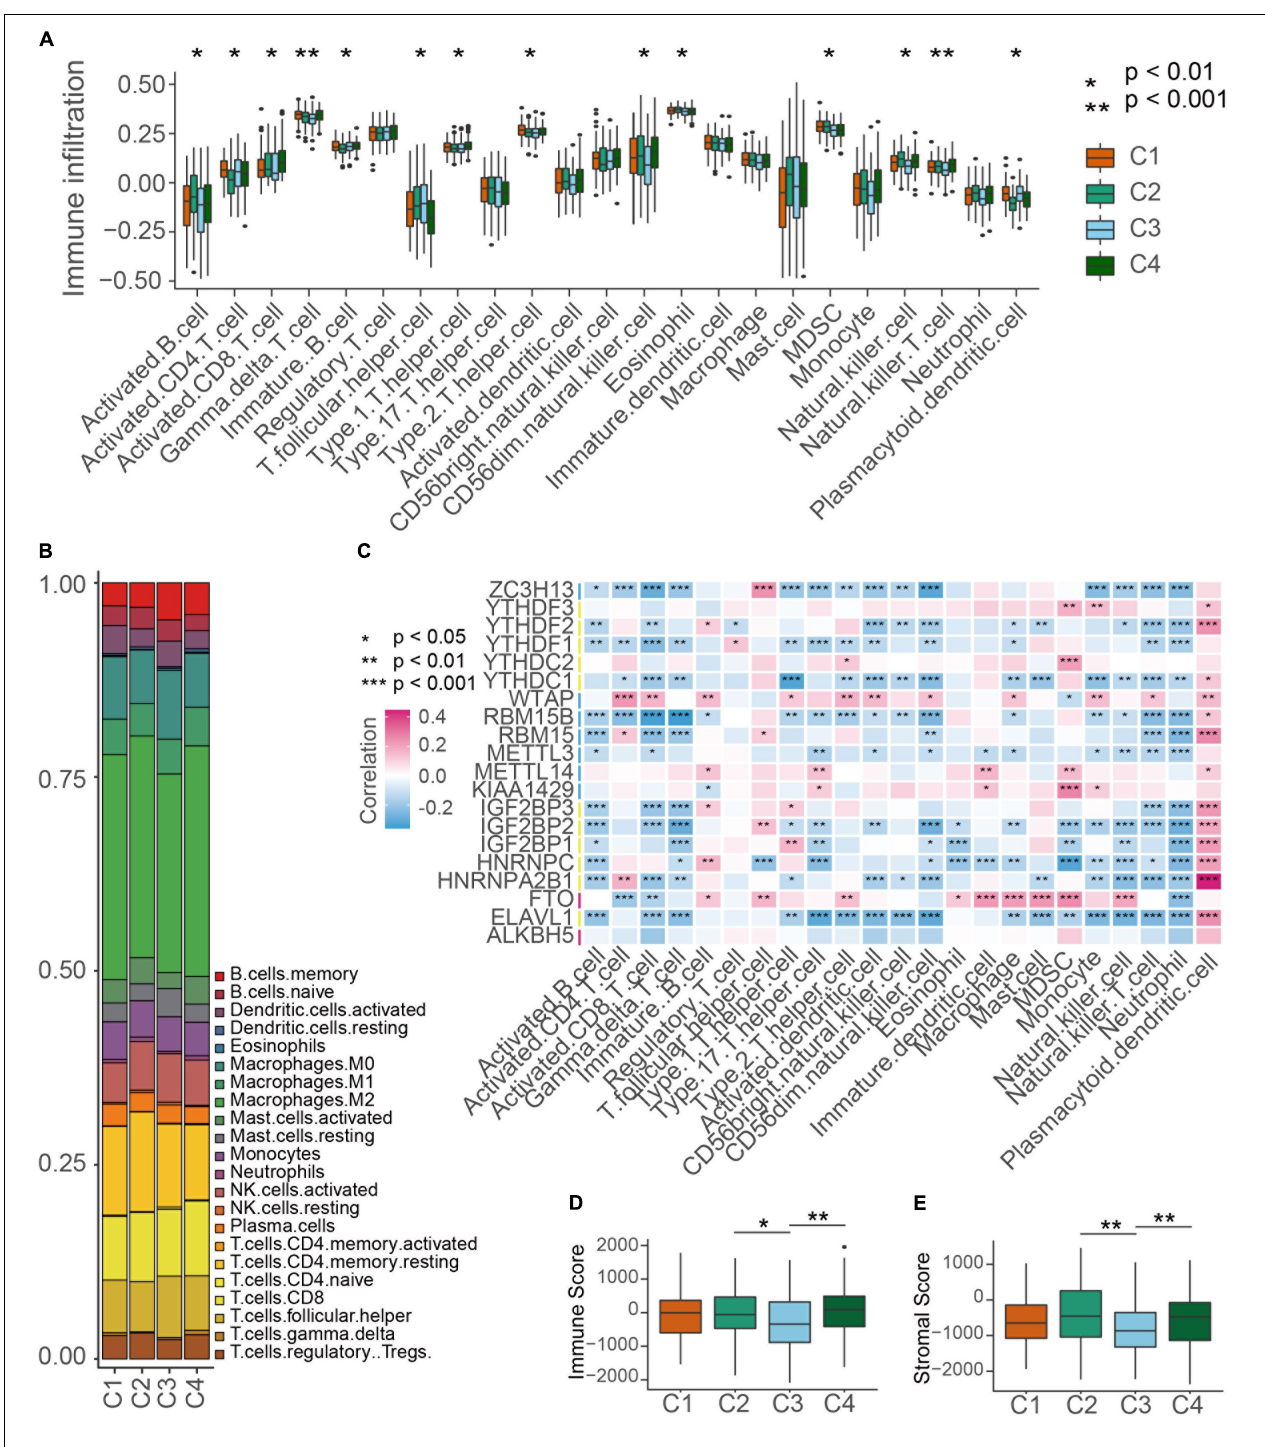
FIGURE 4 | TME cell infiltration characteristics in distinct m 6 A modification patterns. (A) The abundance of each TME infiltrating cell type in four m 6 A modification patterns. The TME infiltrating cell types were defined by ssGSEA methods. The upper and lower ends of the boxes represented interquartile range of values. Kruskal-Wallis test was used to calculate the significance between poor prognosis groups and good prognosis groups. * P < 0.01, ** P < 0.001. (B) The component differences of immune cells among the four m 6 A modification patterns analyzed by CIBERSORT. (C) The correlation between each m 6 A regulator mRNA levels and each TME infiltration cell type ssGSEA scores using spearman analyses. Red color means positive correlated and blue color means negative correlated. * P < 0.05, ** P < 0.01, *** P < 0.001. (D,E) Differences of immuneScore and stromaScore in four subgroups by ESTIMATE. * P < 0.05, ** P < 0.01.